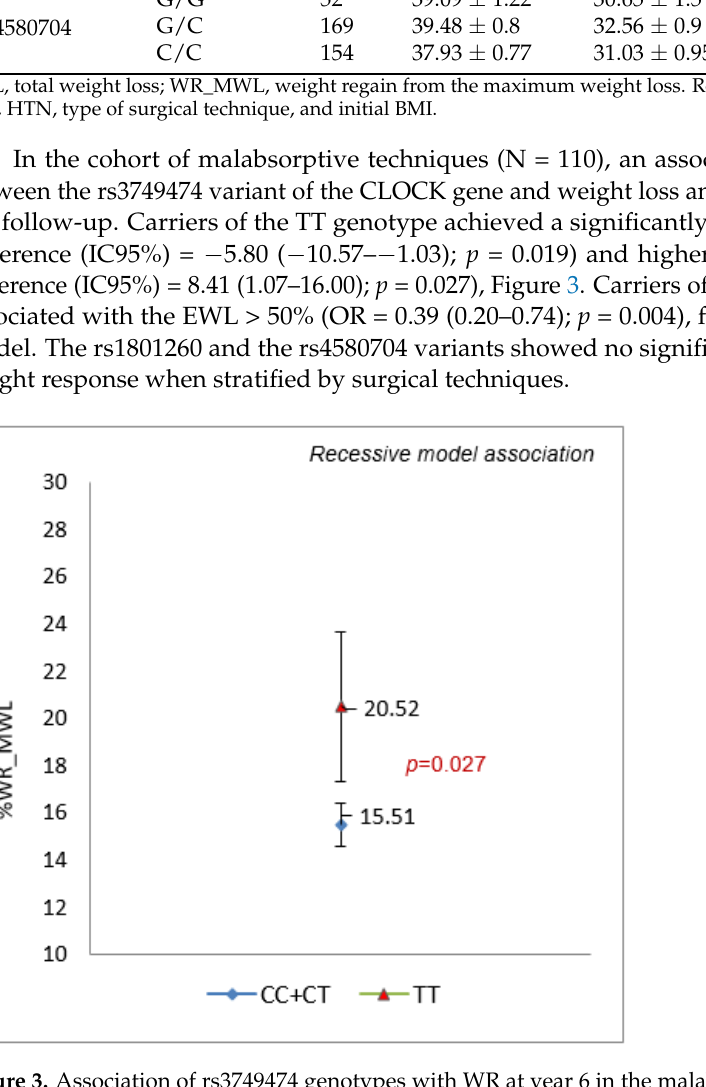
Figure 3. Association of rs3749474 genotypes with WR at year 6 in the malabsorptive cohort.